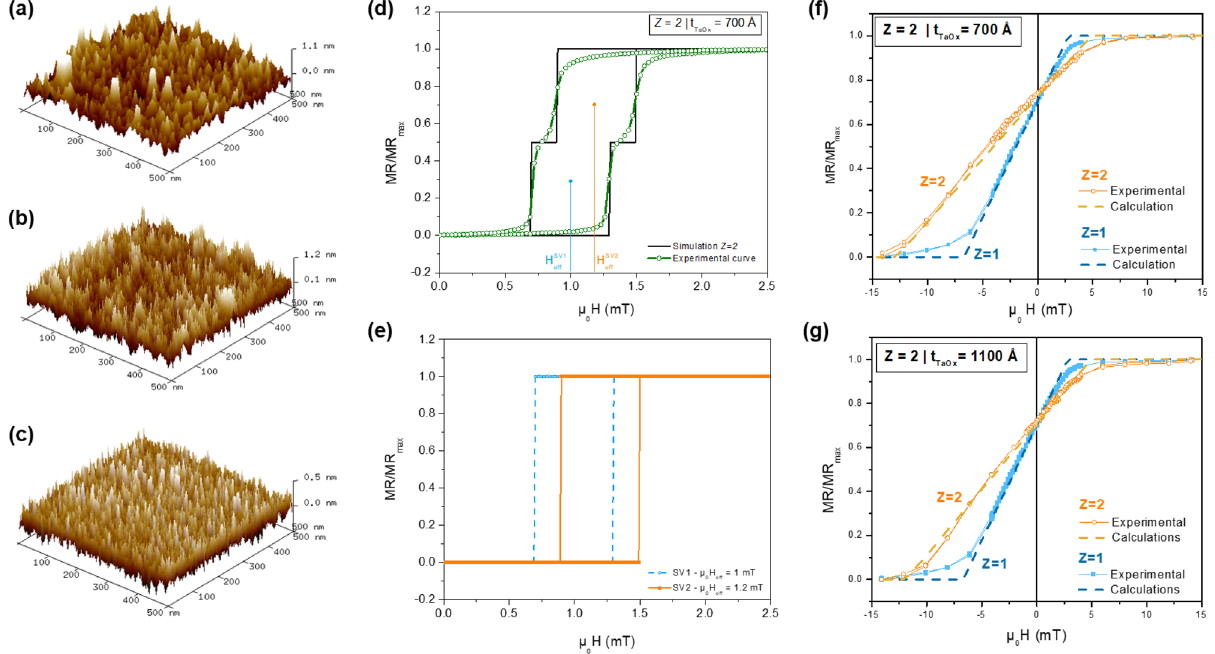
Figure 2. AFM images measured on the top surface of ( a ) a single spin-valve Z = 1 , ( b ) a spin-valve /TaOx 700 Å/spin-valve Z = 2 , and a ( c ) 700 ÅTaOx film. Transfer curves for ( d , e ) unpatterned samples and ( f , g ) micropatterned sensor. ( d ) Comparison for Z = 2 of an experimental normalized R(H) transfer curve for a spacer of TaOx 700 Åand the corresponding simulated output. ( e ) simulated curves for each individual spin- valve in the system considering the bottom one ( SV 1 ) with lower offset field ( H off ) than the top one ( SV 2 ) with higher offset field. Input parameters for analytical calculations include H k and M sat values in Table 1. Normalized transfer curves comparing the double packed spin-valves ( Z = 2 ) with TaOx thickness of ( f ) 700 Åand ( g ) 1100 Å, and comparison with the single spin-valve structures. Experimental data for patterned structures with w = 2 µ m and l = 40 µ m is compared with the analytic calculations using Eq. (3) and input parameters of Table